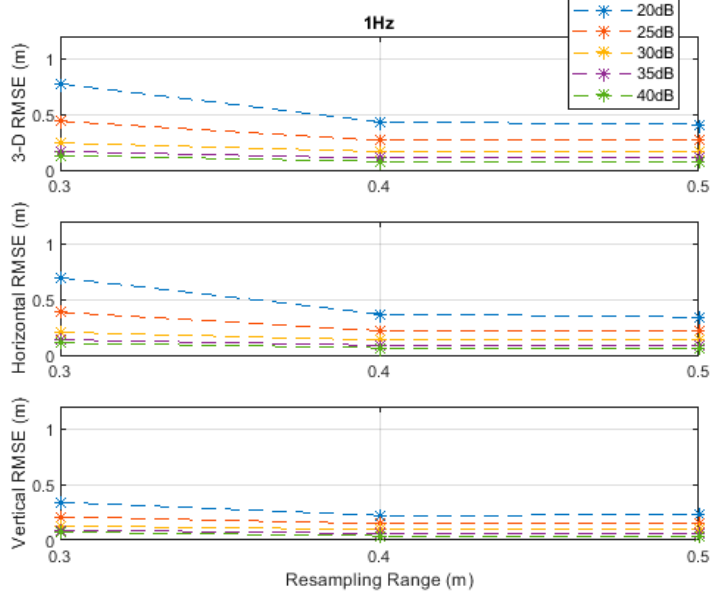
Figure 8. Anchor node arrangement and the horizontal circular path.